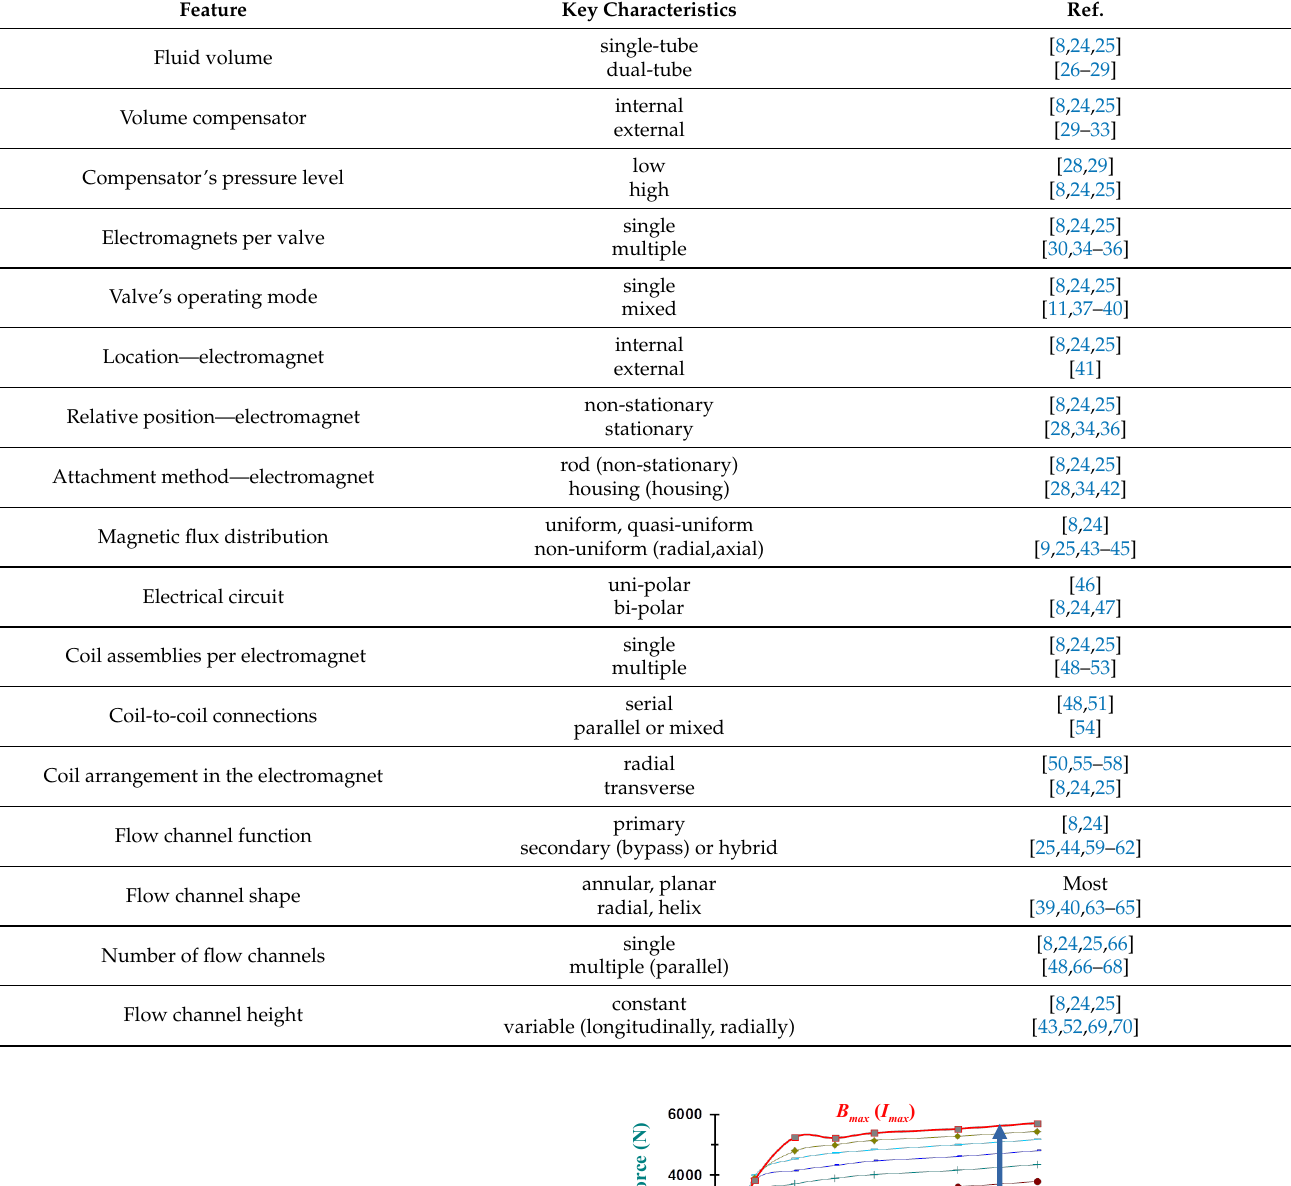
Table 1. Flow-mode MR actuators: classification features include exemplary references.